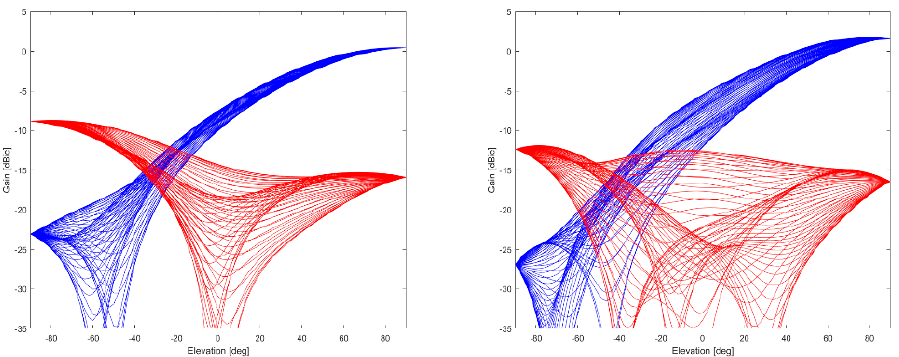
Figure 6. Gain in dBic (RHCP in blue, LHCP in red, different lines represent different azimuth values with a resolution of 5.625 deg) over elevation angle at L1/E1 ( left ) and L5/E5 ( right ) of ANYWAVES GNSS All-Bands Antenna (data provided by manufacturer).